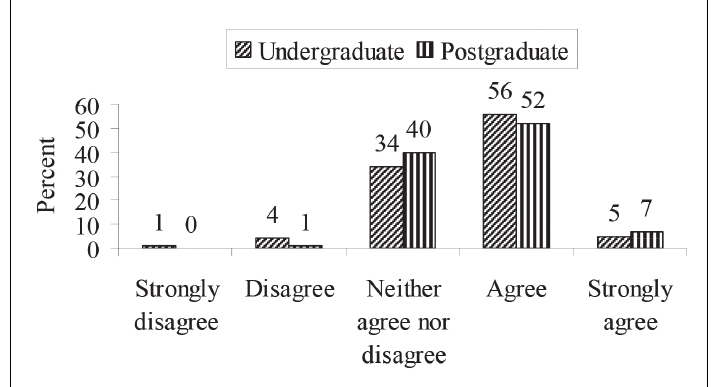
Figure. Distribution of undergraduate and post- graduate students’ evaluations of the relevance of study materials presented in the e-learning envi-